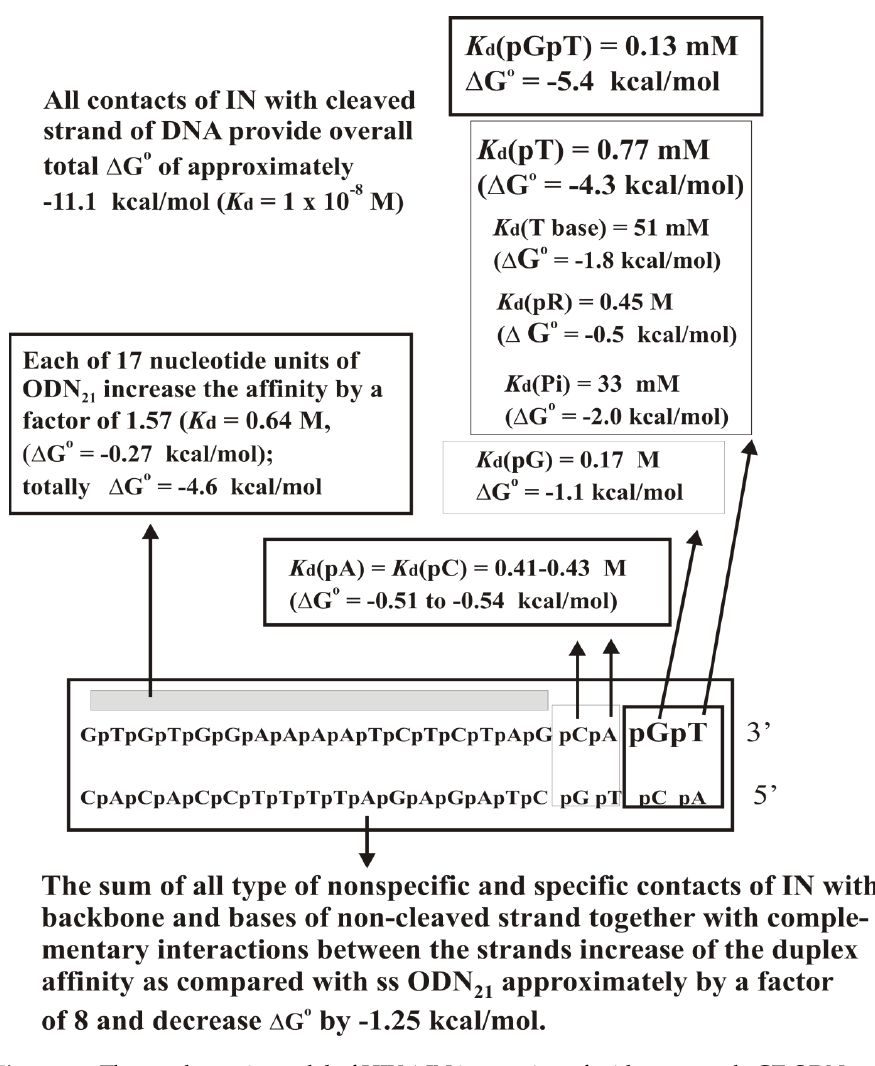
Figure 13. Thermodynamic model of HIV-1 IN interaction of with cognate ds GT-ODN 21 containing 3’-terminal-specific GT dinucleotide. ∆ G ◦ values characterizing different contacts between the enzyme and DNA strands are shown